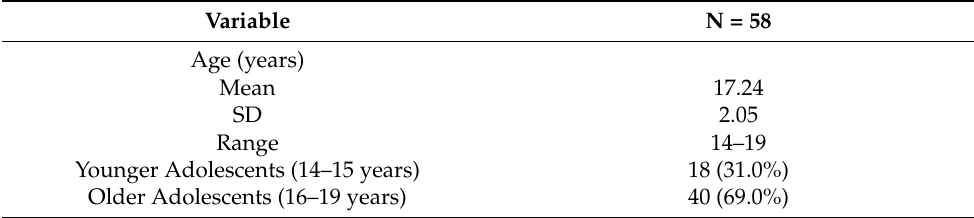
Table 1. Demographic and clinical